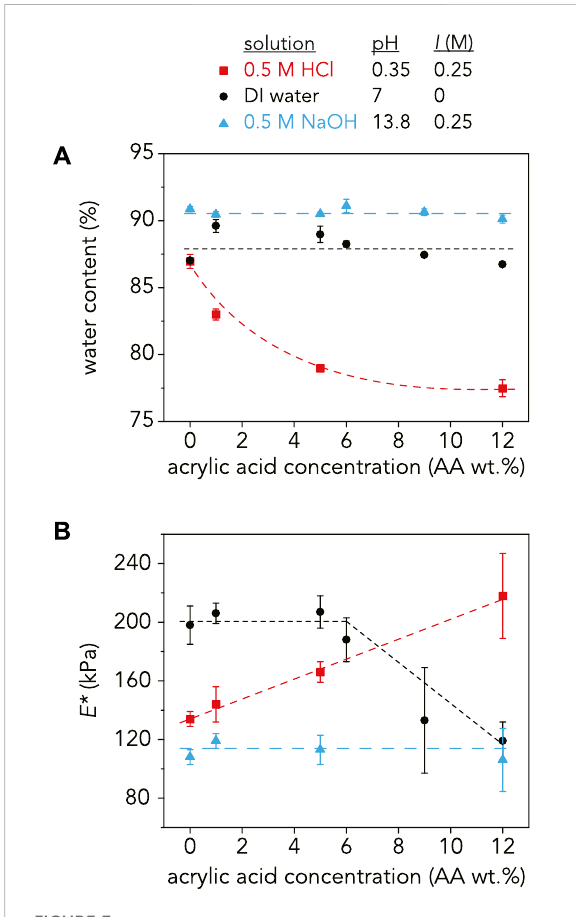
function of AA concentration at pH = 0.35 (red squares), pH = 7 (black circles), and pH = 13.8 (blue triangles). At pH = 0.35,